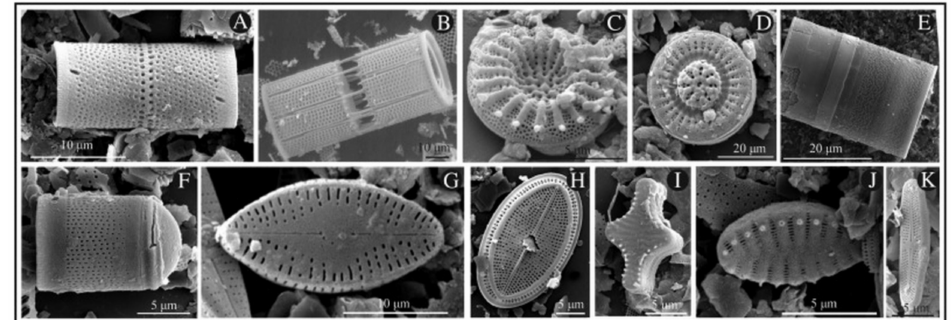
Figure 1. Common diatom species. ( A ) Aulacoseira ambigua , ( B ) Aulacoseira granulata , ( C ) Stephanodiscus cf. minutulus , ( D) Discostella stelligera , ( E ) Melosira undulata , ( F ) Orthoseira dendroteres , ( G ) Diadesmis confervacea , ( H ) Cocconeis placentula , ( I ) Staurosira construens , ( J ) Staurosirella pinnata , ( K ) Achnanthidium minutissimum . Reprinted from [16], copyright (2017), with permission from